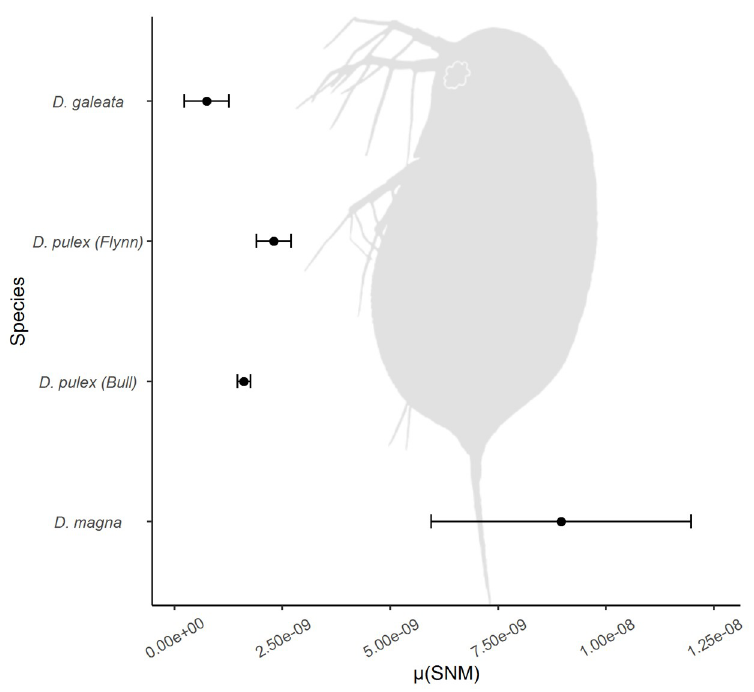
Fig 2. Haploid mutation rate (+/- 95% c.f.) of Daphnia galeata in comparison to other directly measured mutation rates of the